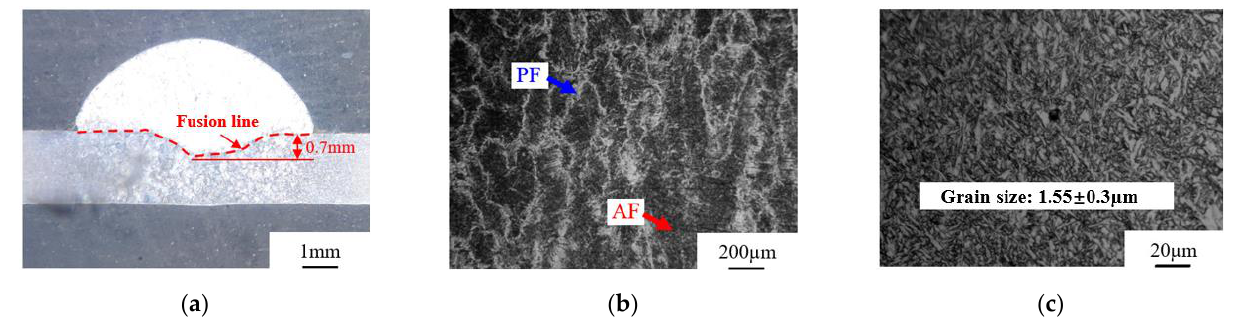
Figure 21. Morphology and structure of weld ( I = 60 A, I p = 485 A): ( a ) macroscopic morphology of weld; ( b ) microstructure at the center of the weld; ( c ) high magnification image of the AF phase.